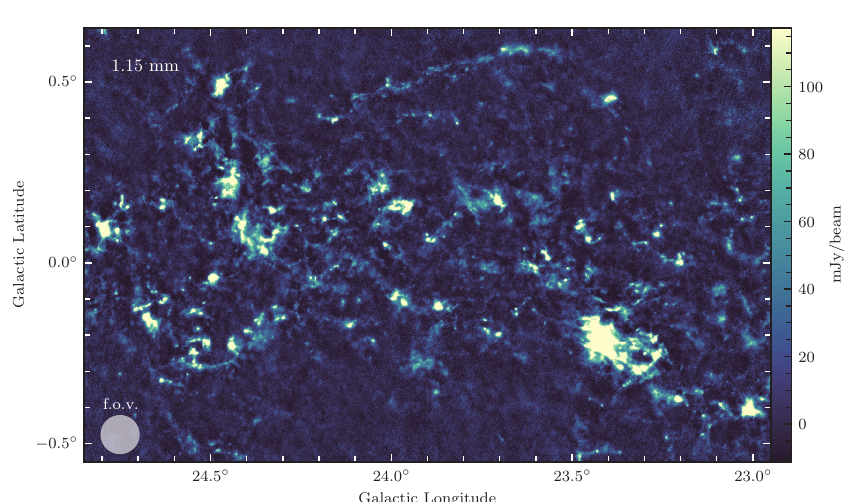
Figure 1. GASTON 1.2 mm map of the (cid:31) = 24 ◦ region of the Galactic plane, cropped to show the approximate extent of the region that should reach the target sensitivity. The grey filled circle in the bottom left corner of the image matches the NIKA2 field-of-view